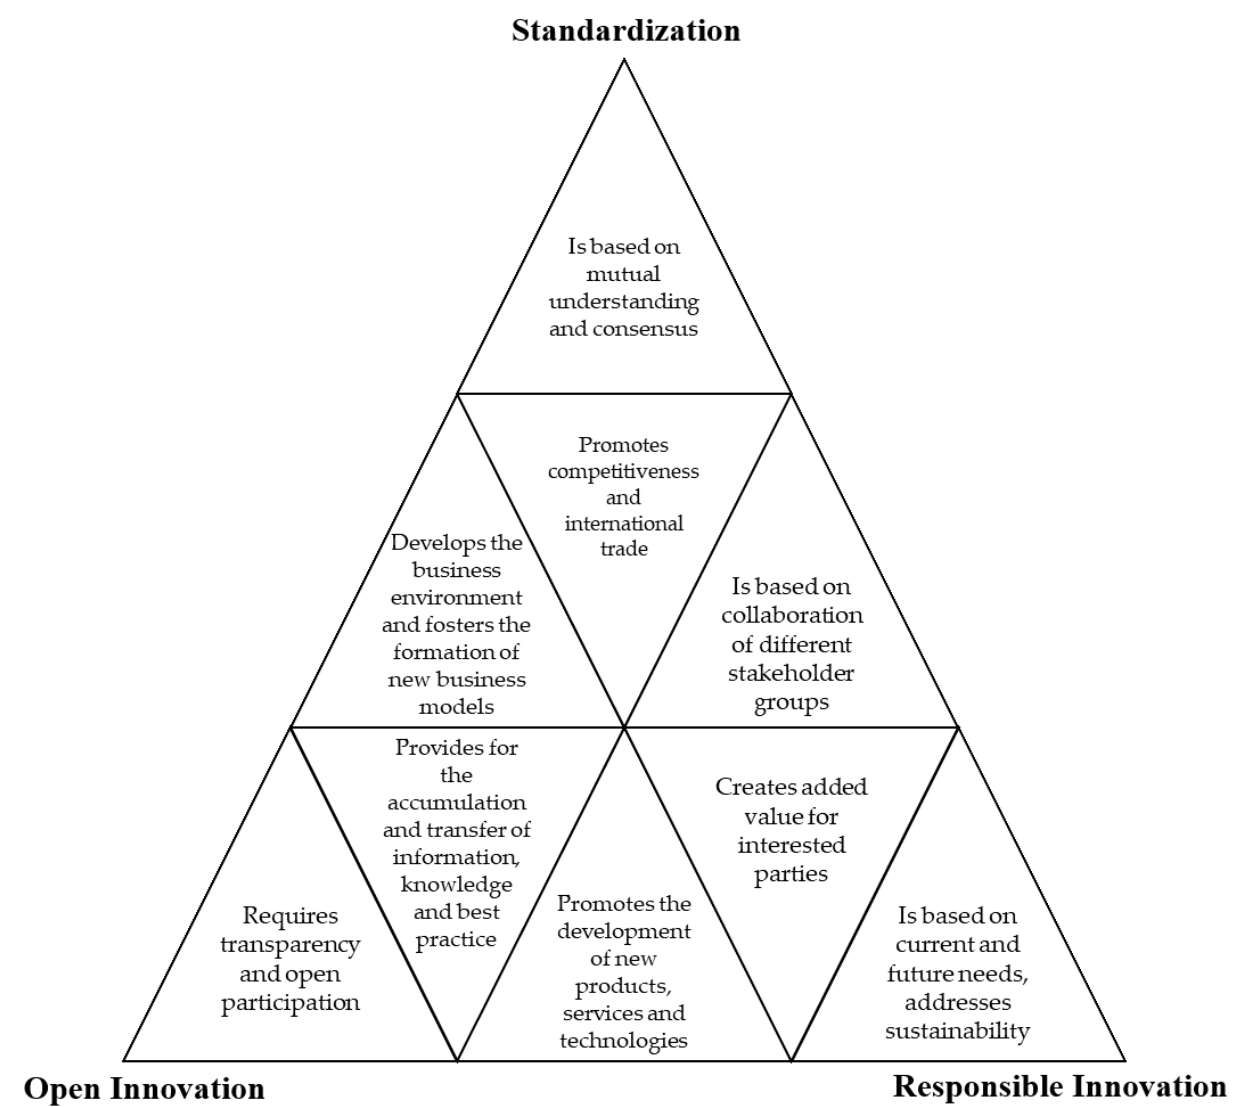
Figure 1. The common aspects of standardization, open innovation and responsible innovation (created by the authors).